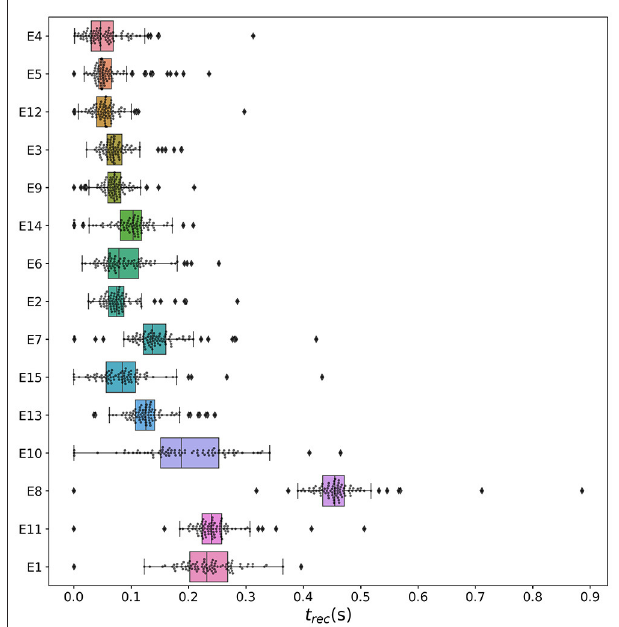
FIGURE 14 | Recruitment times of all brain areas and all patients. The patients are sorted from top to bottom according to their median shortest path length, calculated by listing all the shortest path lengths of all areas to the EZ and then locating the number in the center of that distribution. Gray dots and diamonds show individual recruitments (we use two different symbols to highlight those values that are beyond the boxplot whiskers); boxes cover the 2nd and 3rd quartile and whiskers extend 1.5 times the IQR (whiskers are asymmetric, comprising the most extreme observed values that are within 1.5 the upper or lower quartiles). Parameters as in Figure 10